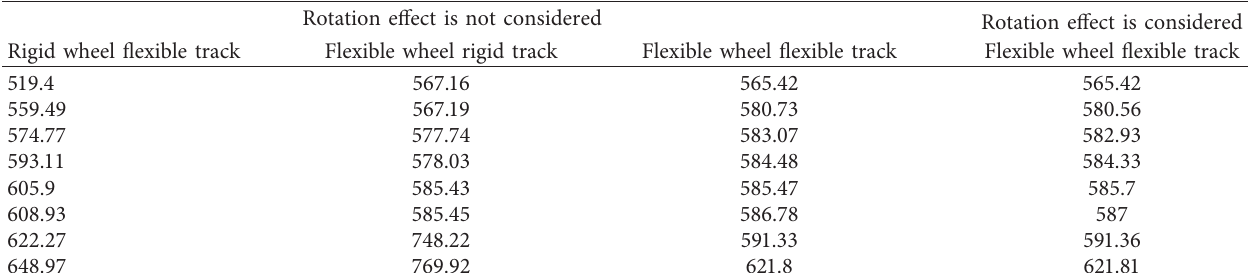
Figure 8: Vibration mode of third-order wheelset bending. Table 3: Natural frequency of rotor system of wheelset